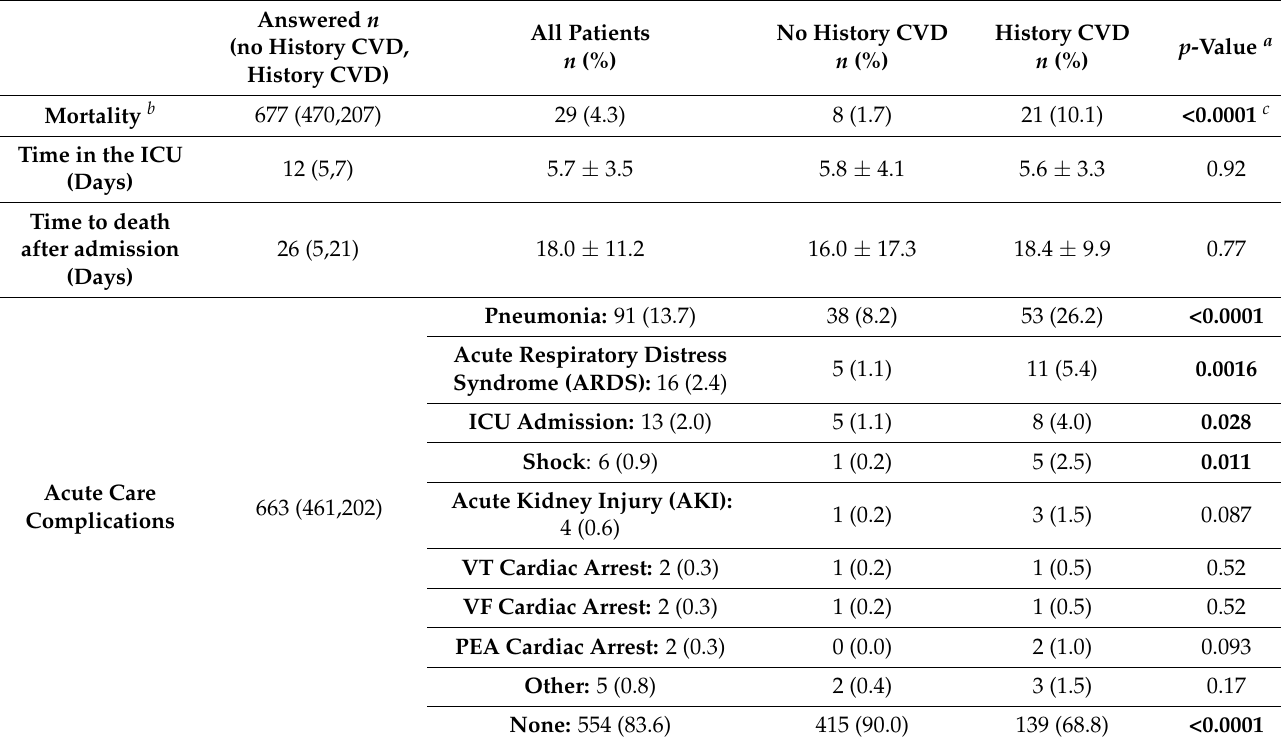
Table 5. Mortality and acute care complications in registry patients with or without a history of